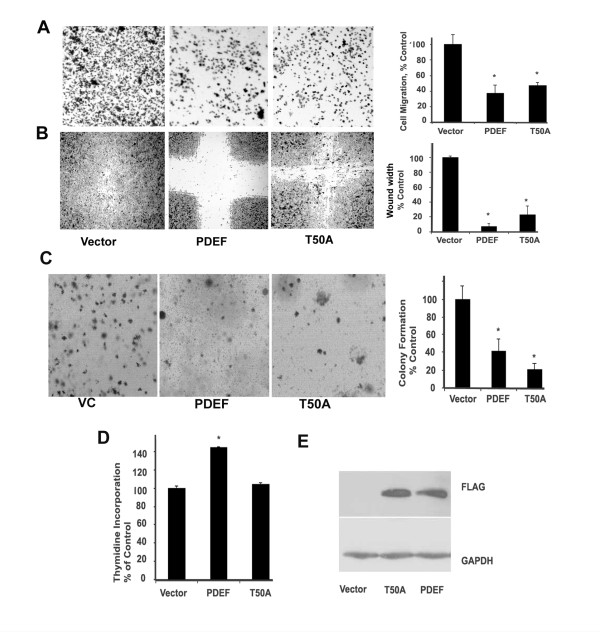
Effect of re-introduction of PDEF on directional migration, trans-well migration and anchorage independent growth in prostate cancer cells. A, Migration of PC3 cells expressing PDEF or PDEF T50A through Transwell membranes as described in Materials and Methods. B, PDEF overexpression decreases directional cell migration (in vitro wound healing migration of these cells). C, Representative photomicrographs from experiments testing colony formation as described in Materials and Methods. D, 3H-thymidine incorporation in PC3 PDEF overexpressing cells measured as described in Materials and Methods. E, Relative expression level of PDEF in these cell lines. Asterisks indicate significance levels of p < 0.05 with respect to controls.